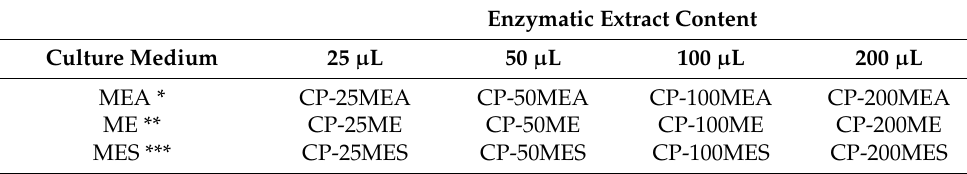
Enzymatic Extract Content